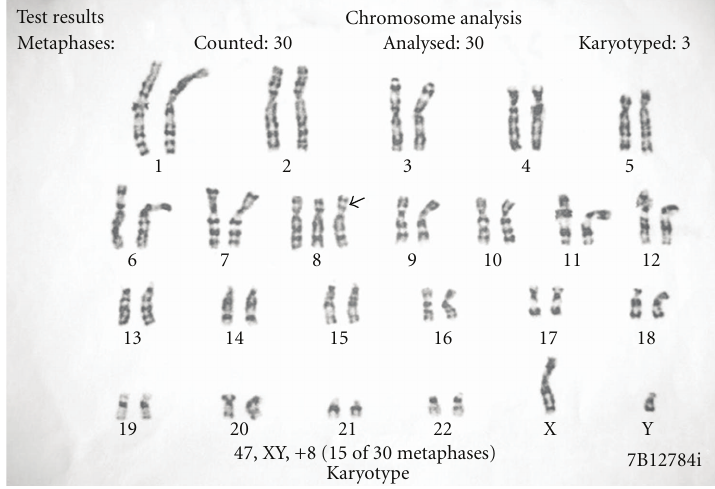
Figure 2: Karyotyping showing trisomy